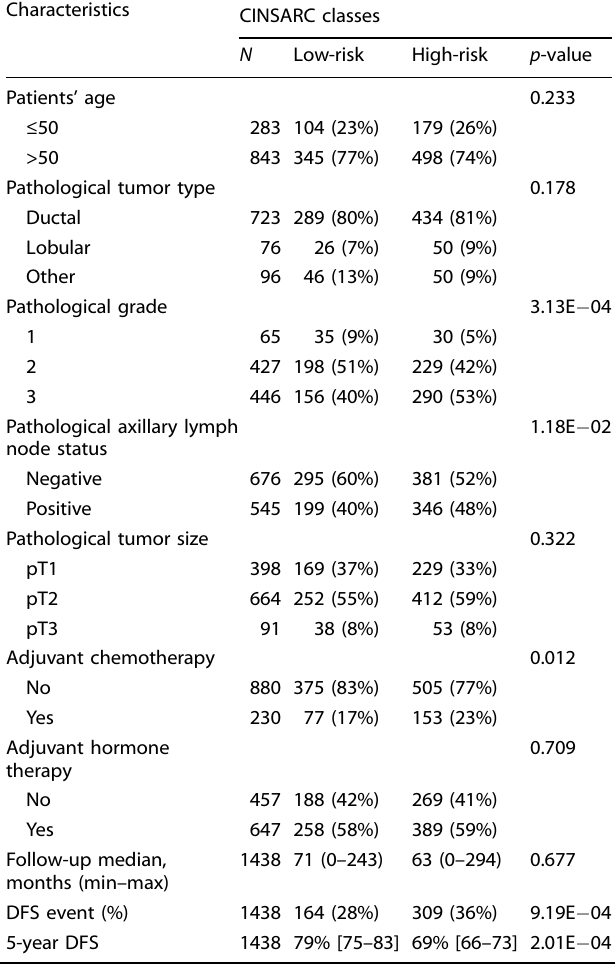
Table 2. Correlations of CINSARC classes with clinicopathological characteristics in Luminal B breast cancer